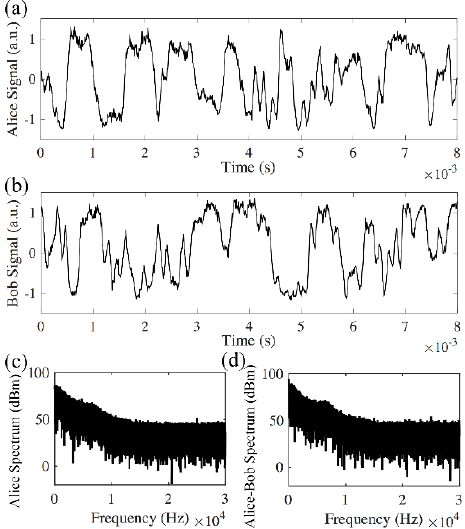
Figure 4. Direct detection of the signal after 240 km transmission with 26 km delays from both Alice and Bob. ( a ) Signal received by Alice; ( b ) signal received by Bob; ( c ) Alice’s spectrum; ( d ) differential spectrum between Alice and Bob has the same amplitude as Alice’s spectrum.